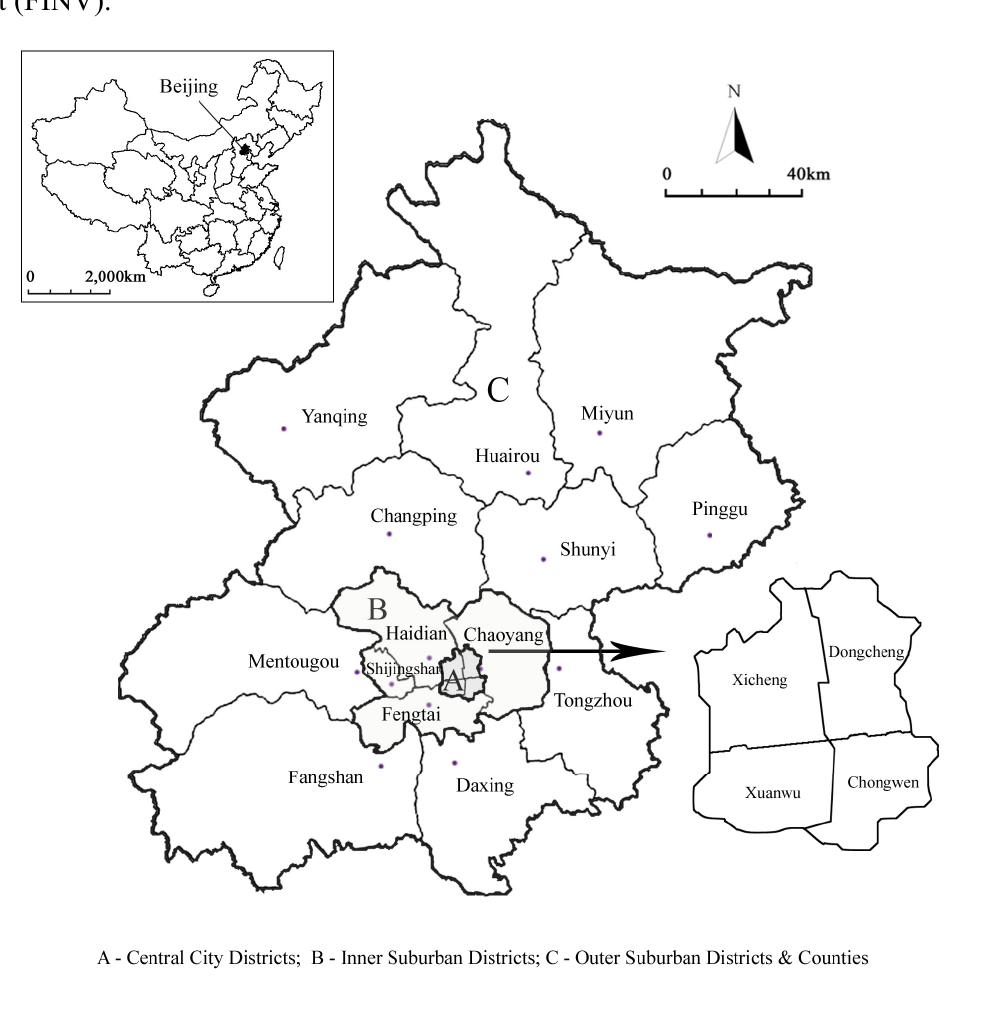
Figure 1. Administrative Structure of Beijing